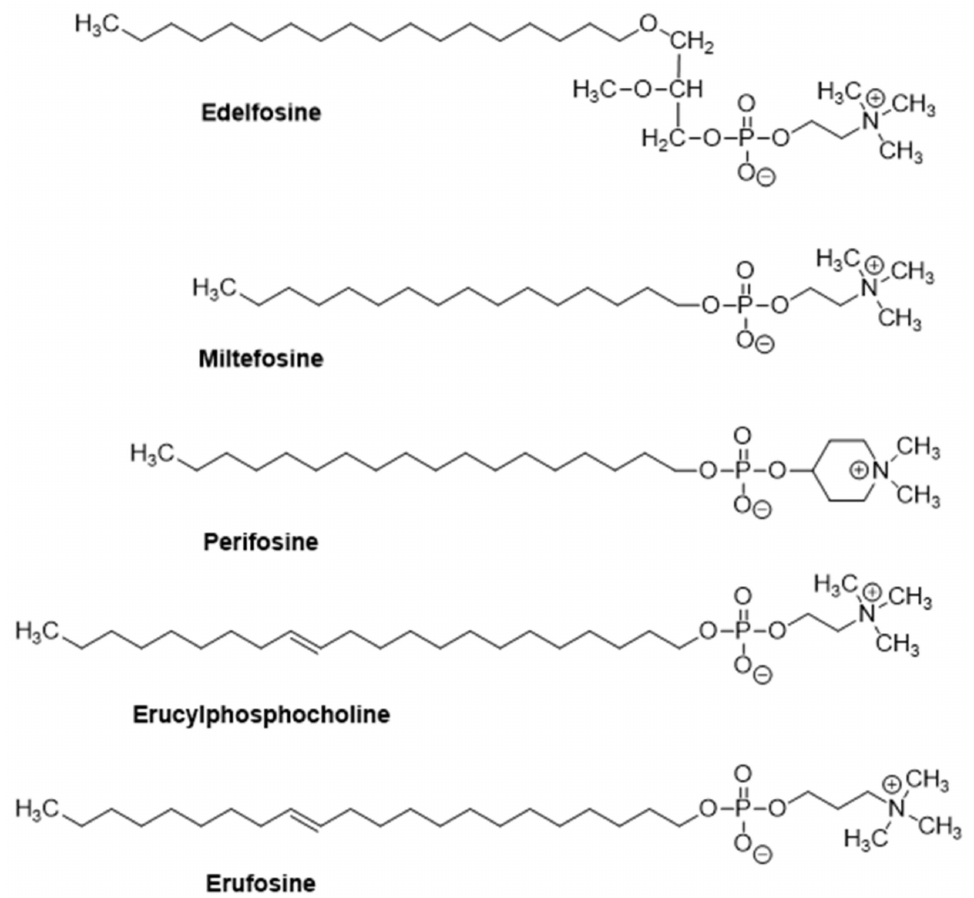
Figure 1. Chemical structures of some clinically relevant alkylphospholipid